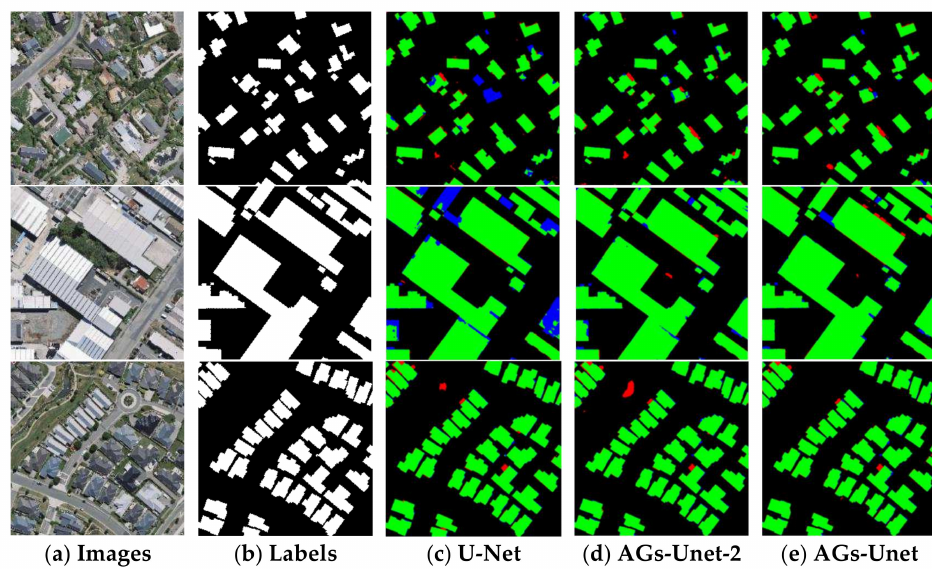
Figure 10. Comparison of aBlation experimental results. The first two columns are aerial images and ground truth, respectively. Columns 3–5 are building extraction results of U-Net, our proposedAGs-Unet-2 with 2 AG in U-Net, and AGs-Unet, respectively. The green, red, blue, and black pixels of the maps represent the predictions of true positive, false positive, false negative, and true negative, respectively.